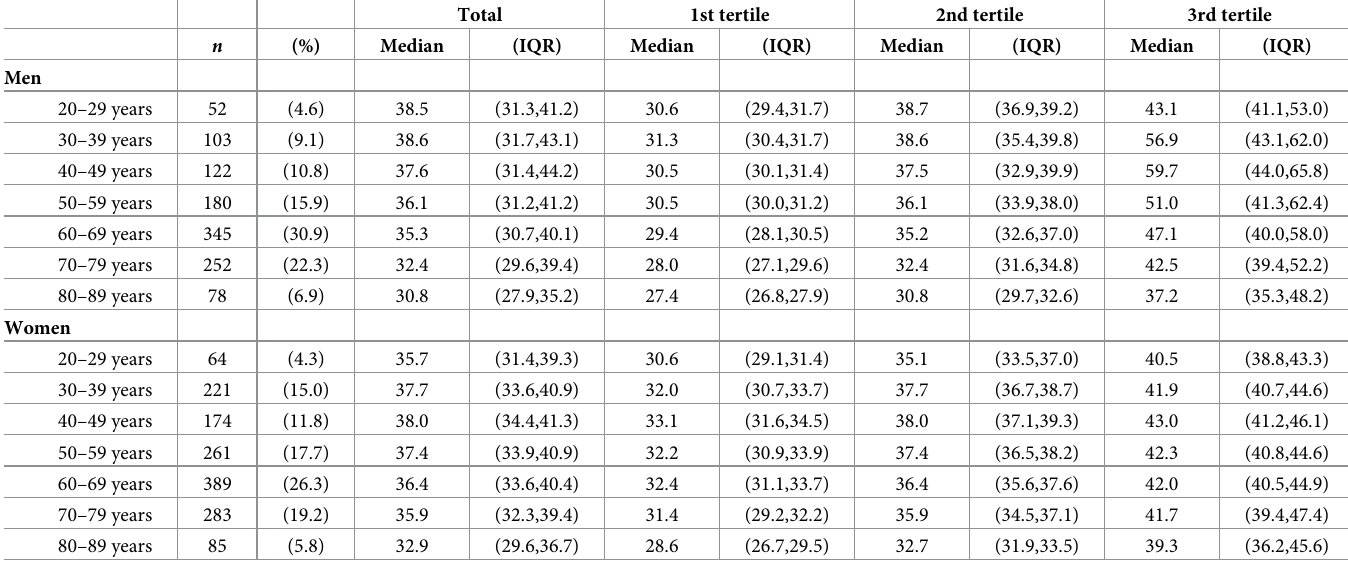
Table 2. Distribution of physical activity index by sex and age